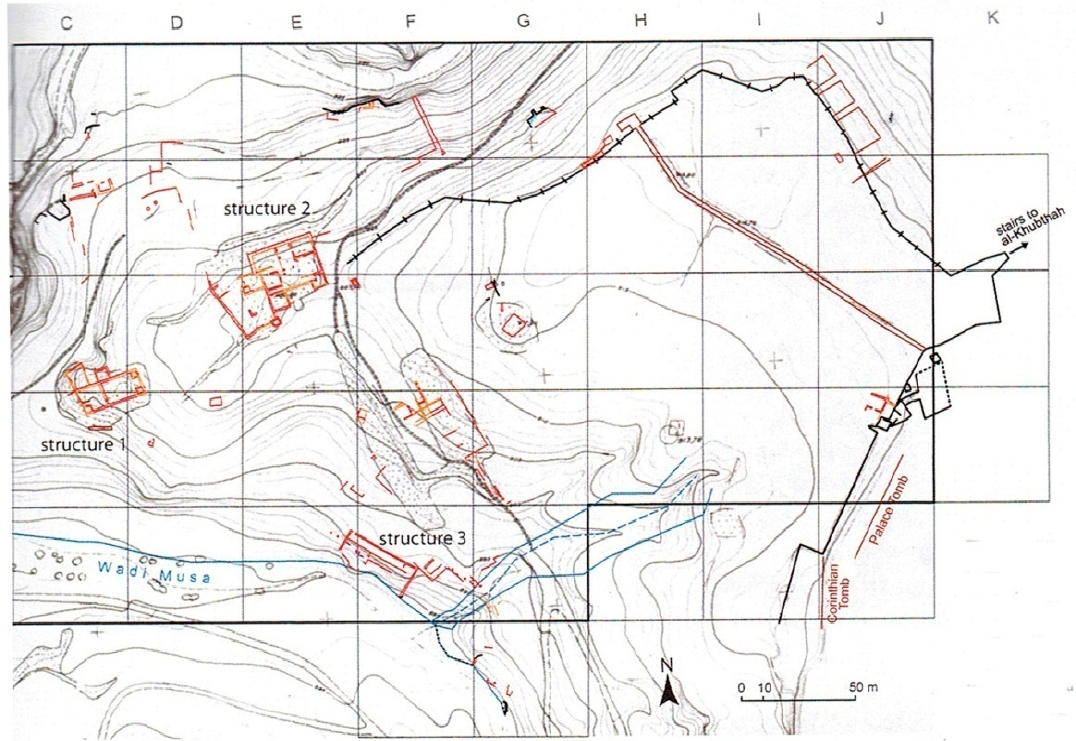
Figure 15. Royal compound structures 1, 2, and 3 in the Wadi Mataha area [18].